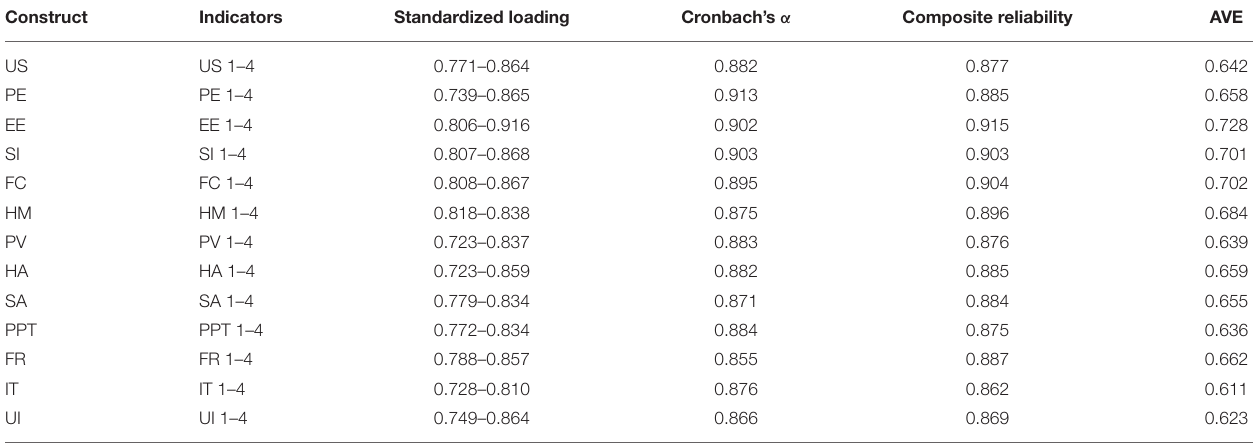
TABLE 2 | Convergent validity and reliability (entire